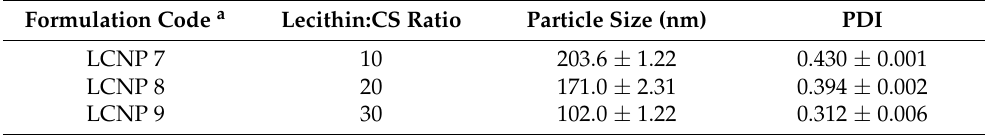
Table 2. Effect of lecithin:CS ratio on the particle size and PDI of RTG-LCNP (n = 3). Formulation Code